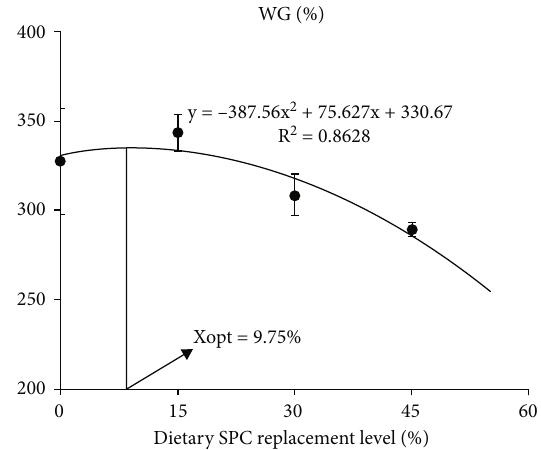
Figure 1: The relationship between the dietary SPC replacement levels and the WG of large yellow croaker fed the experimental diets. The Xopt represents the optimal dietary SPC protein levels for the maximum WG of large yellow croaker. WG: weight